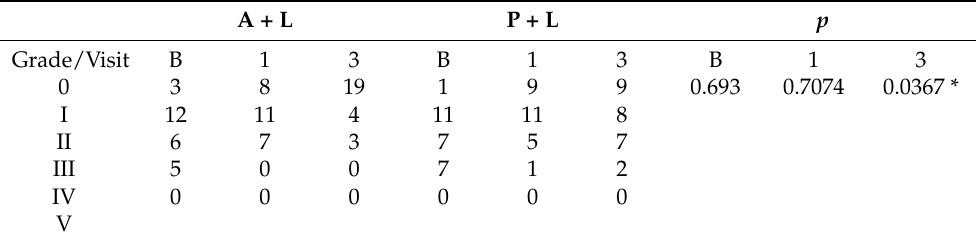
Grading staining with lissamine green in dry-eye patients exposed to the oral study formulation + lubricant or placebo +